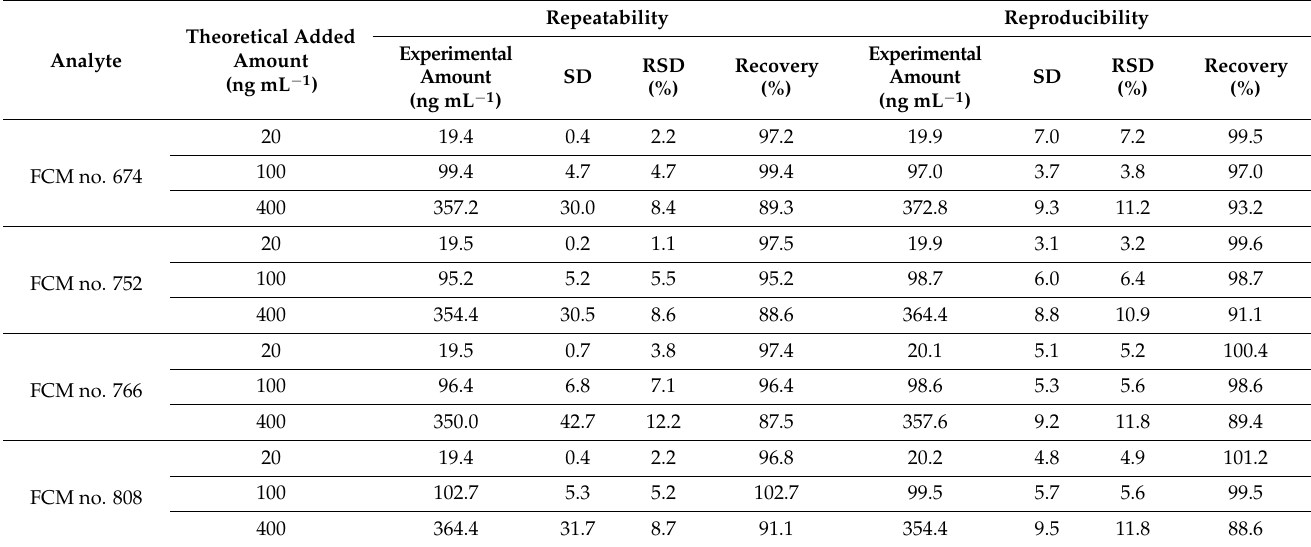
Table 4. Repeatability and reproducibility results for all the target analytes in food simulant D1 (50% v/v ethanol in H 2 O). Theoretical Added Analyte